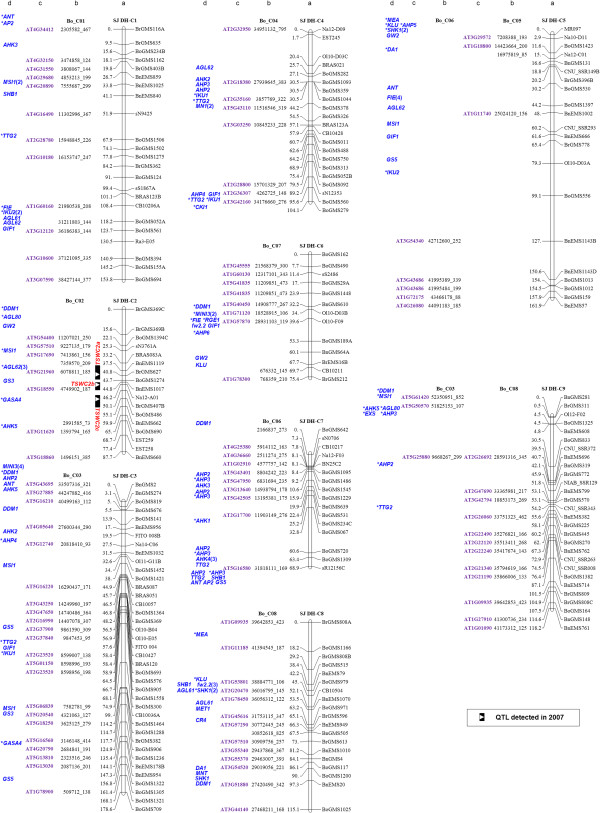
Seed weight/size gene distribution map of B. napus (C genome). Column a presents the genetic linkage groups of the SJ DH population. The nomenclature of LGs follows the rules proposed by the Multinational Brassica Genome Project [37]. Each of the LGs is represented with a vertical bar with the locus position (in cM) on the left and SSR loci names on the right. The QTLs information (peak, interval and name) of TSW were on the left-hand of the LGs. Column b lists the homologous colinear loci in B. rapa or B. oleracea. The numbers designate the physical position in B. rapa or B. oleracea chromosome with the length of amplification fragment. Column c is the Arabidopsis gene codes corresponding to the homologous loci. Column d lists the homologous genes of seed size or weight identified in B. rapa and B. oleracea. Genes that are in good fit into both Arabidopsis and B. rapa/B. oleracea physical positions are marked with asterisks. Numbers in brackets are the tandem repeat times of the tandem repeated genes.